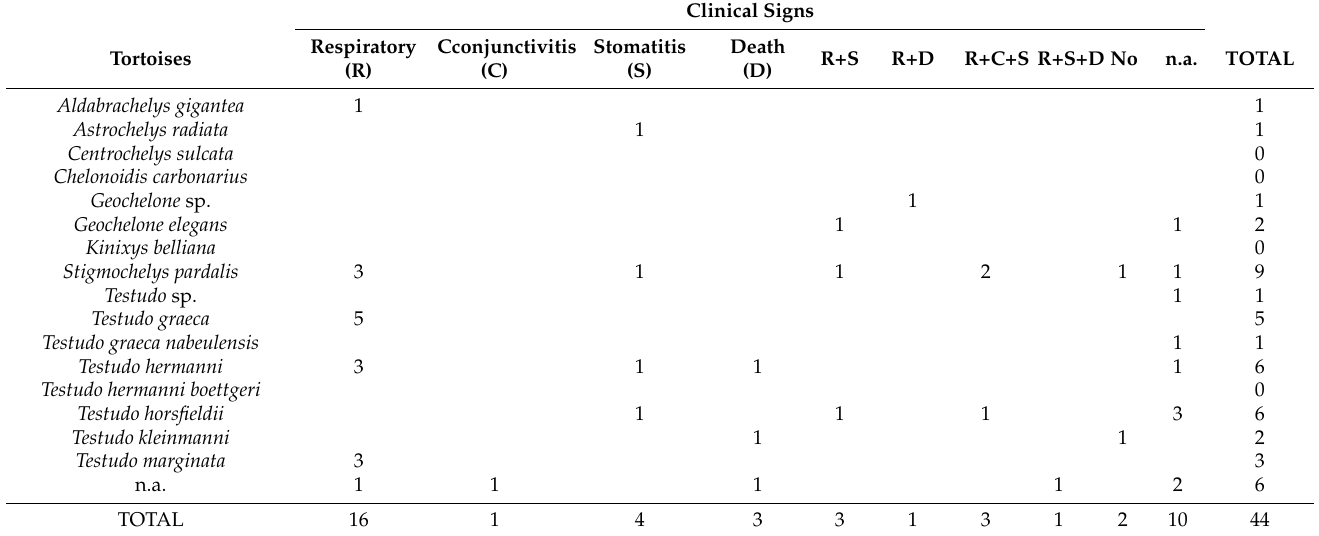
Table 2. Clinical signs observed by veterinarians in different species of tortoise resulted posi- tive for Mycoplasmopsis agassizii by PCR at the time of sampling. Legend: R = respiratory, C = conjunctivitis, S = stomatitis, D = death, No = asymptomatic, n.a. = not available. Clinical Signs Respiratory Cconjunctivitis Stomatitis Death Tortoises (R) (C) (S) (D)